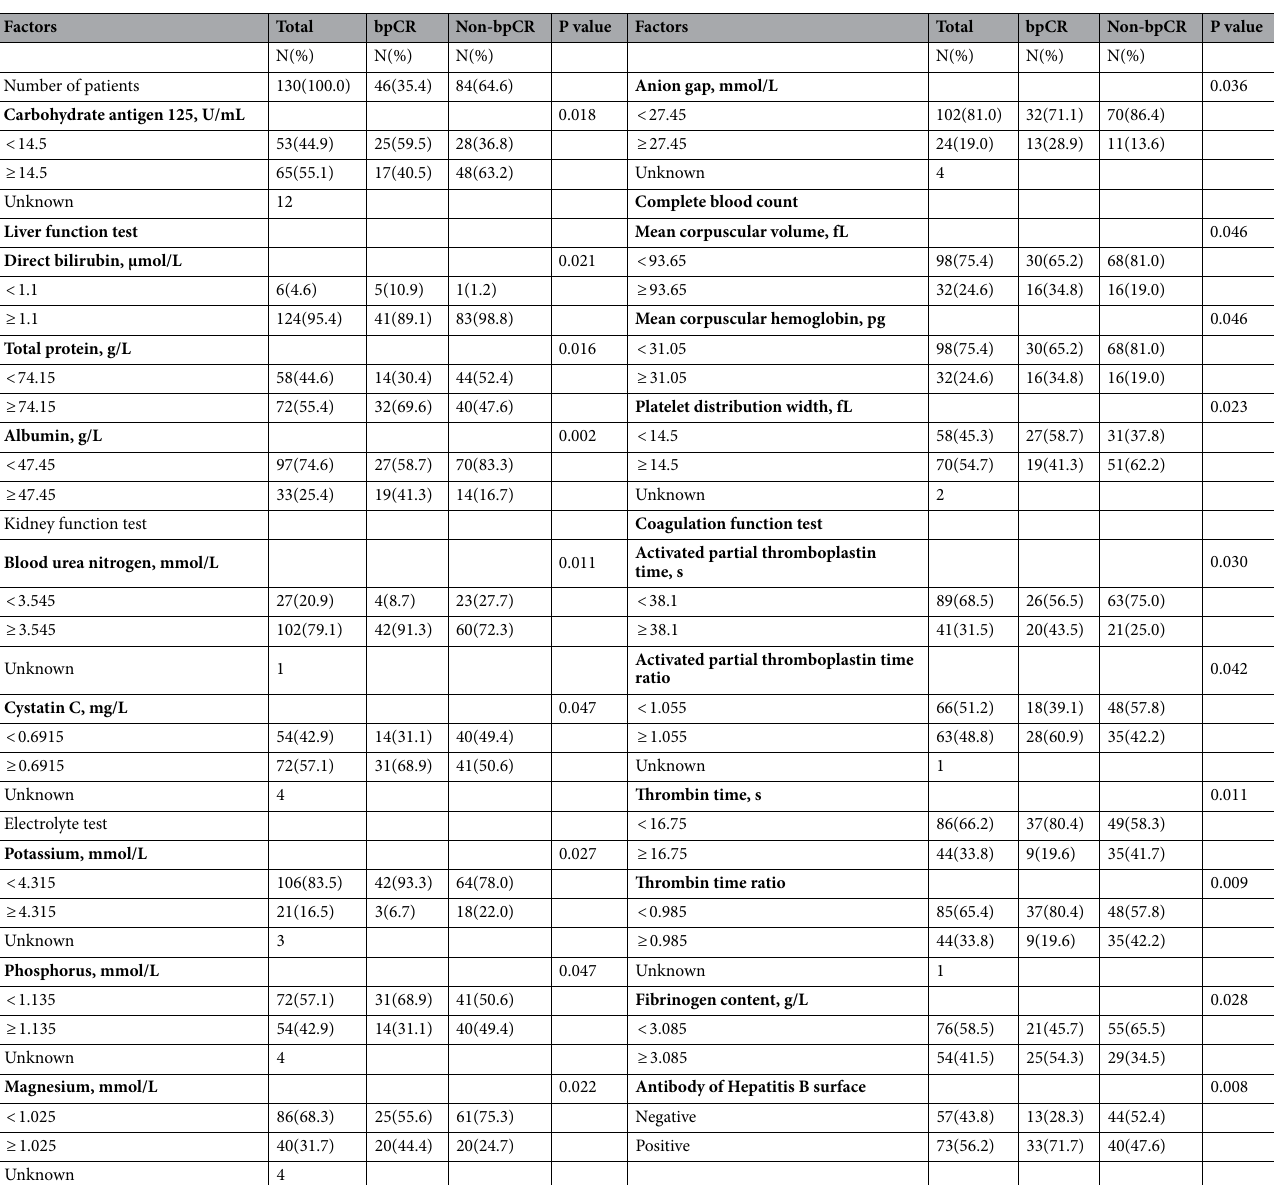
Table 2. Serological indicators related to bpCR rate after NAC in 130 breast cancer patients. NAC neoadjuvant chemotherapy, bpCR breast pathological complete